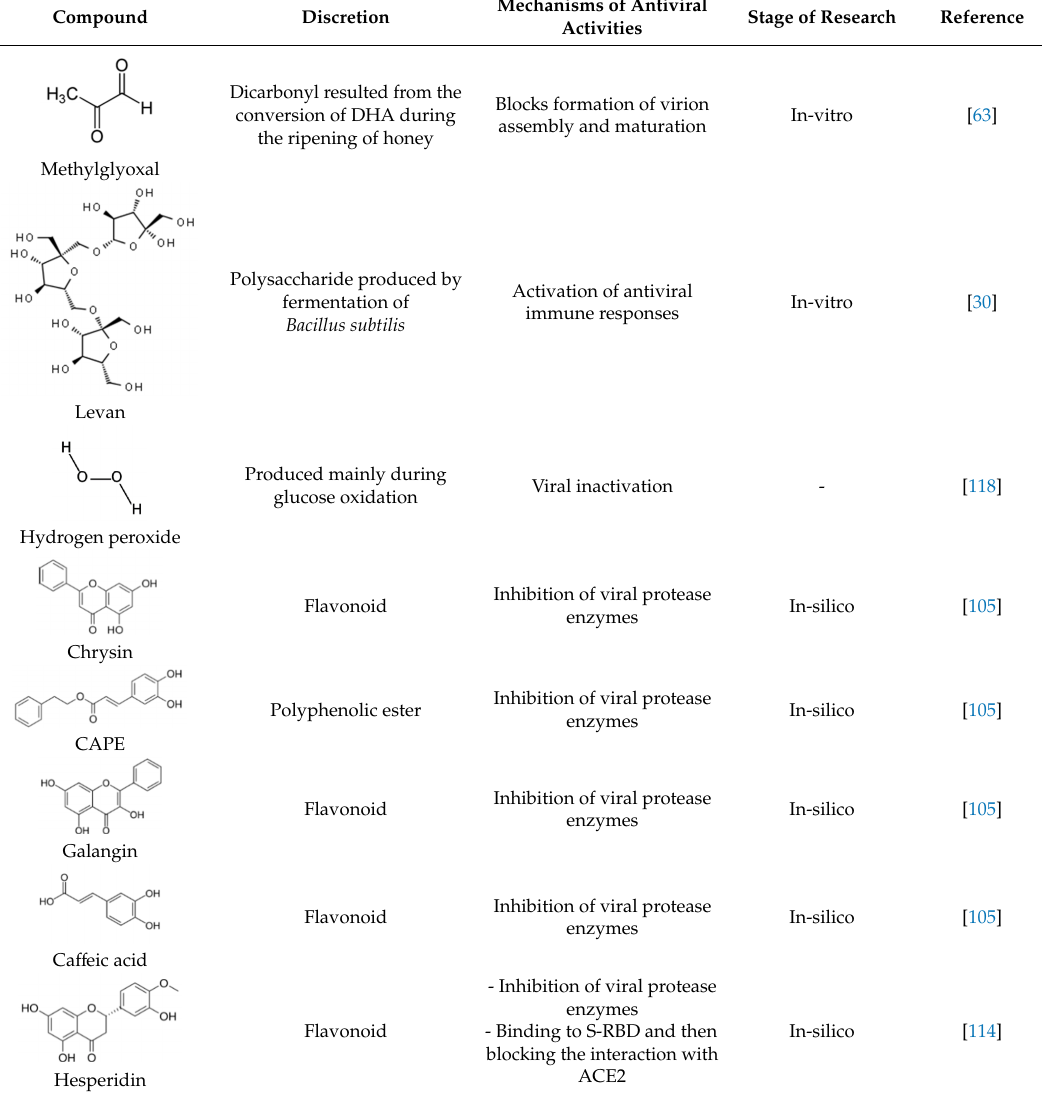
Table 1. Summary of the bioactive chemical compounds in honey that could have antiviral